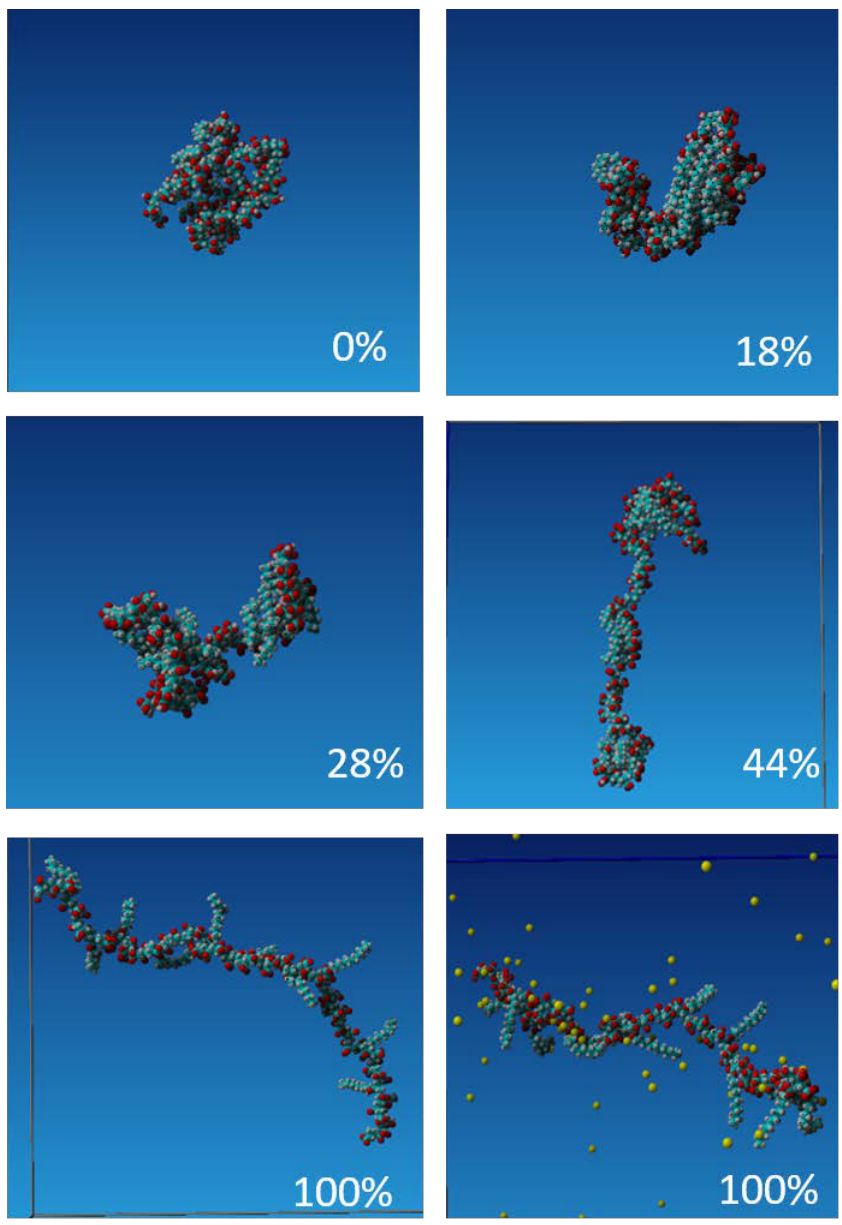
Figure 4. Snapshots obtained after 25 ns molecular dynamics simulations of PAA-g-C 12 OH(15%) with various degrees of charging (marked in the Figure). The condensation of Na + counterions at 100% charged polymer is additionally shown. Legend: oxygen atoms are denoted in red, carbon atoms—blue, hydrogen atoms—grey and Na + ions—yellow.